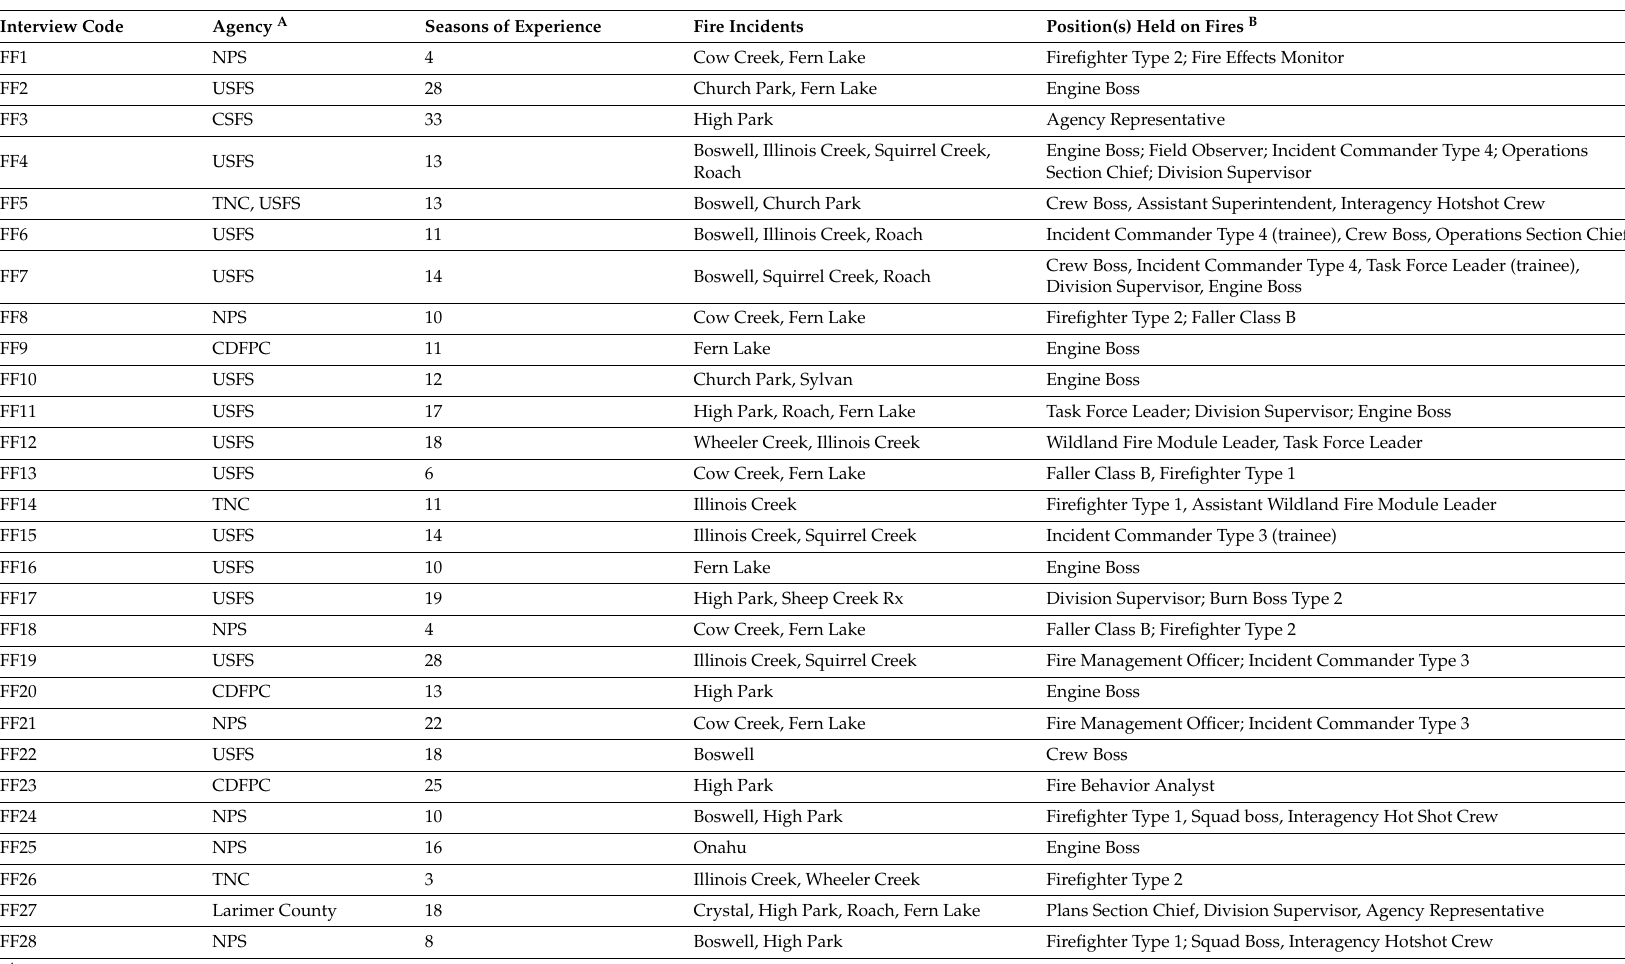
Table 2. Agency a ffi liations, seasons of wildland firefighting experience, fire incident engagement, and position(s) held on fires by those firefighters (FF) interviewed in this